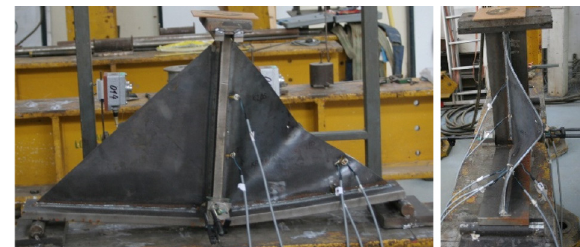
Fig. 2. Specimen B after